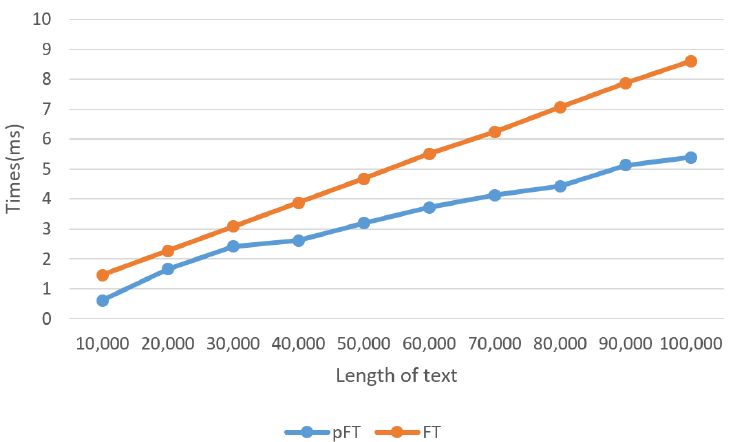
Figure 5. Comparison of execution times of FT and pFT according to n for randomly generated strings when m = 9 and k = 100.